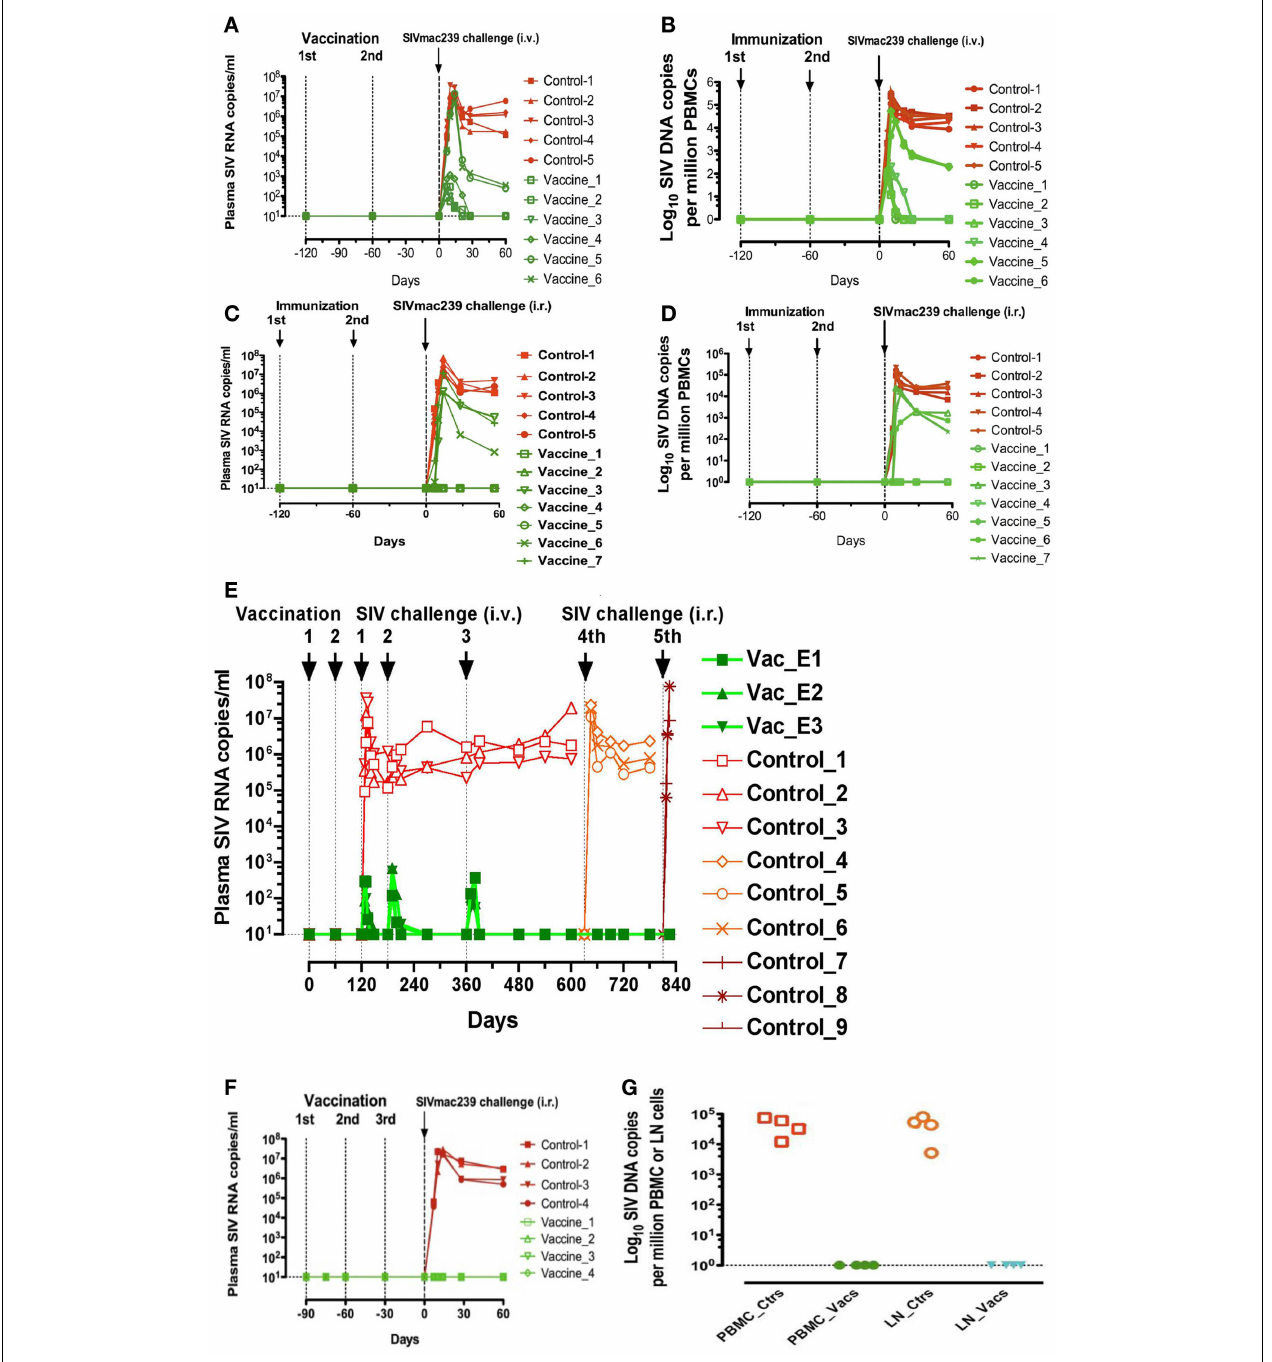
inactivated SIV and BCG; (E) Plasma viral loads of three macaques intravaginally immunized with inactivated SIV and BCG following three intravenous and two intrarectal SIVmac239 challenges; (F,G) Plasma viral loads (F) and PBMC and lymph nodes proviral loads (G) following a challenge performed intrarectally with SIVmac239 (100,000TCID50) in four macaques intragastrically immunized with inactivated SIV and BCG and four control monkeys immunized with inactivated BCG alone (ctrs: control, vacs: vaccinated, LN: lymph